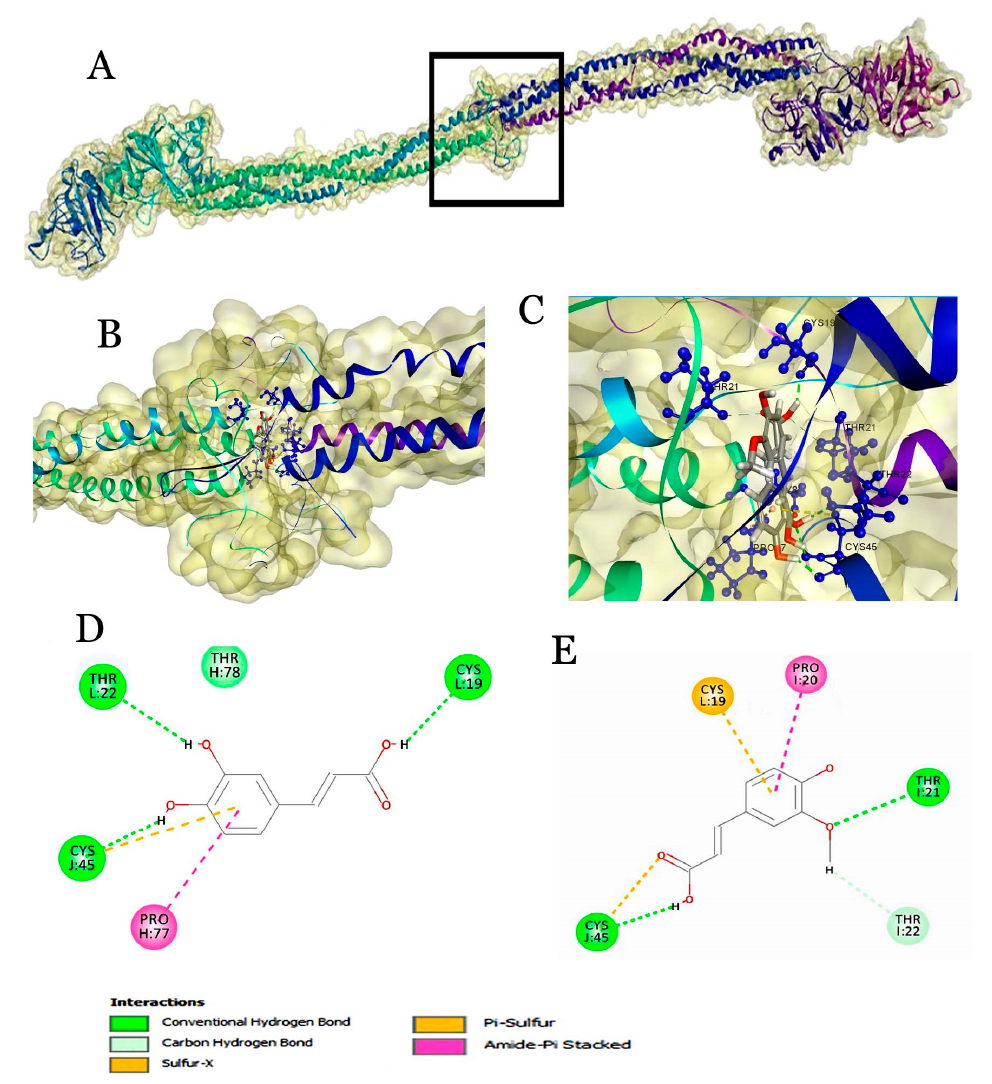
Figure 4. Molecular docking of ligands with fibrinogen. ( A ) Surface view of fibrinogen representing the central nodule (black box) present in the E region; ( B ) Expanded view of the central nodule. ( C ) Interaction of ligands with the binding pocket amino acids of fibrinogen; 2D plot showing interaction with caffeic acid ( D ) and ferulic acid ( E ).